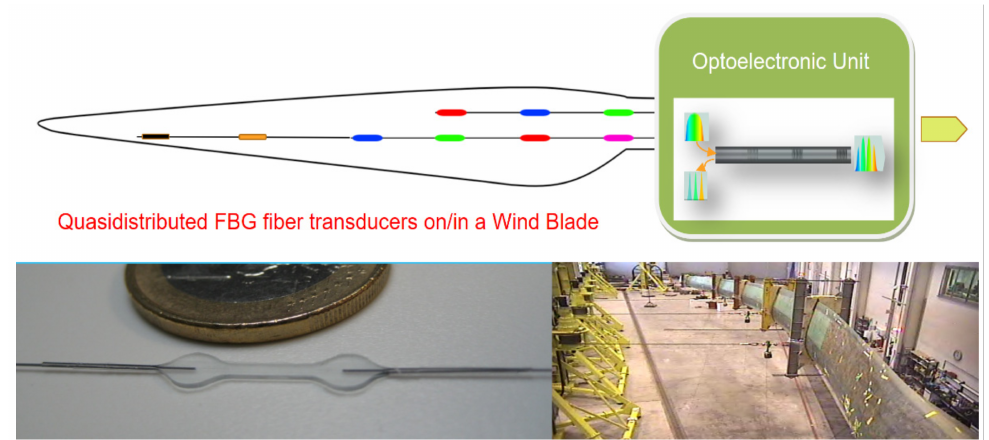
Figure 8. Schematic illustration of a Quasidistributed FBGs Optical Fiber Sensor strain on/in wind blade monitoring. Two fiber transducers are integrated by concatenated Fiber Bragg gratings (FBGs) and interrogate the OU automatically. Below left, a view of the FBG transducer (developed and patented) that is embedded inside the blade structure during its fabrication. Below right is a view of the trials to check the technology up to the blade’s destruction. The appropriate signal processing and algorithmic enables the determination of the quasi distributed strain on/in key places of the blade to reconstruct the more significant strain distribution to know the blade’s structural integrity. Figure made by the author based on material courtesy of the Photonics Engineering Group of UC and